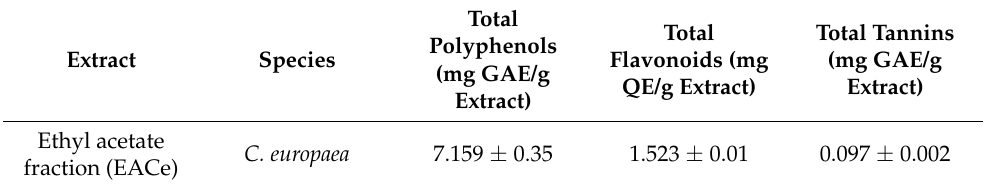
Table 1. Total phenolic, flavonoid and tannin contents of C. europaea ( n = 3).